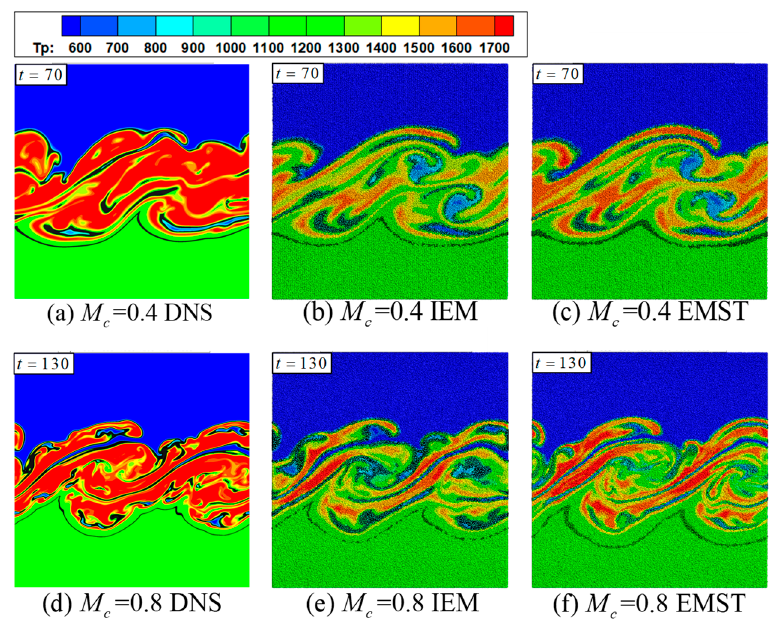
Figure 16. Instantaneous results of temperature at particle level calculated with hydrogen/air reaction. The black circle marks the low values of progress variable C, i.e., 0.1 < C < 0.3.